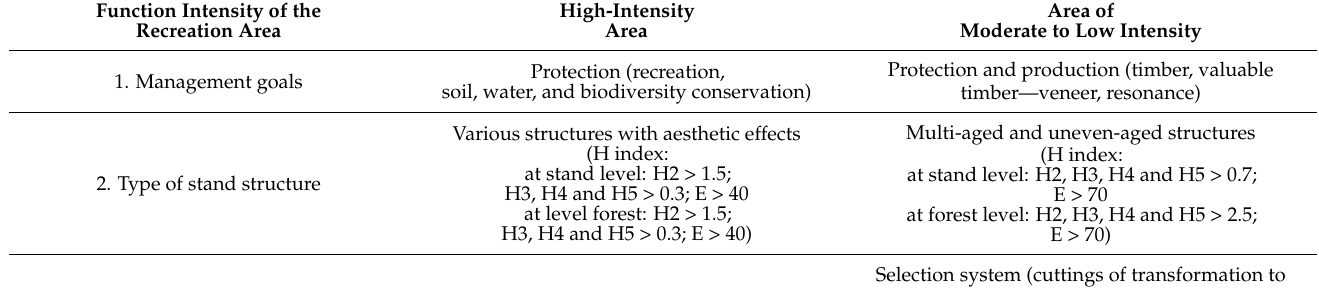
Table 6. Management goals and silvicultural prescriptions for recreation